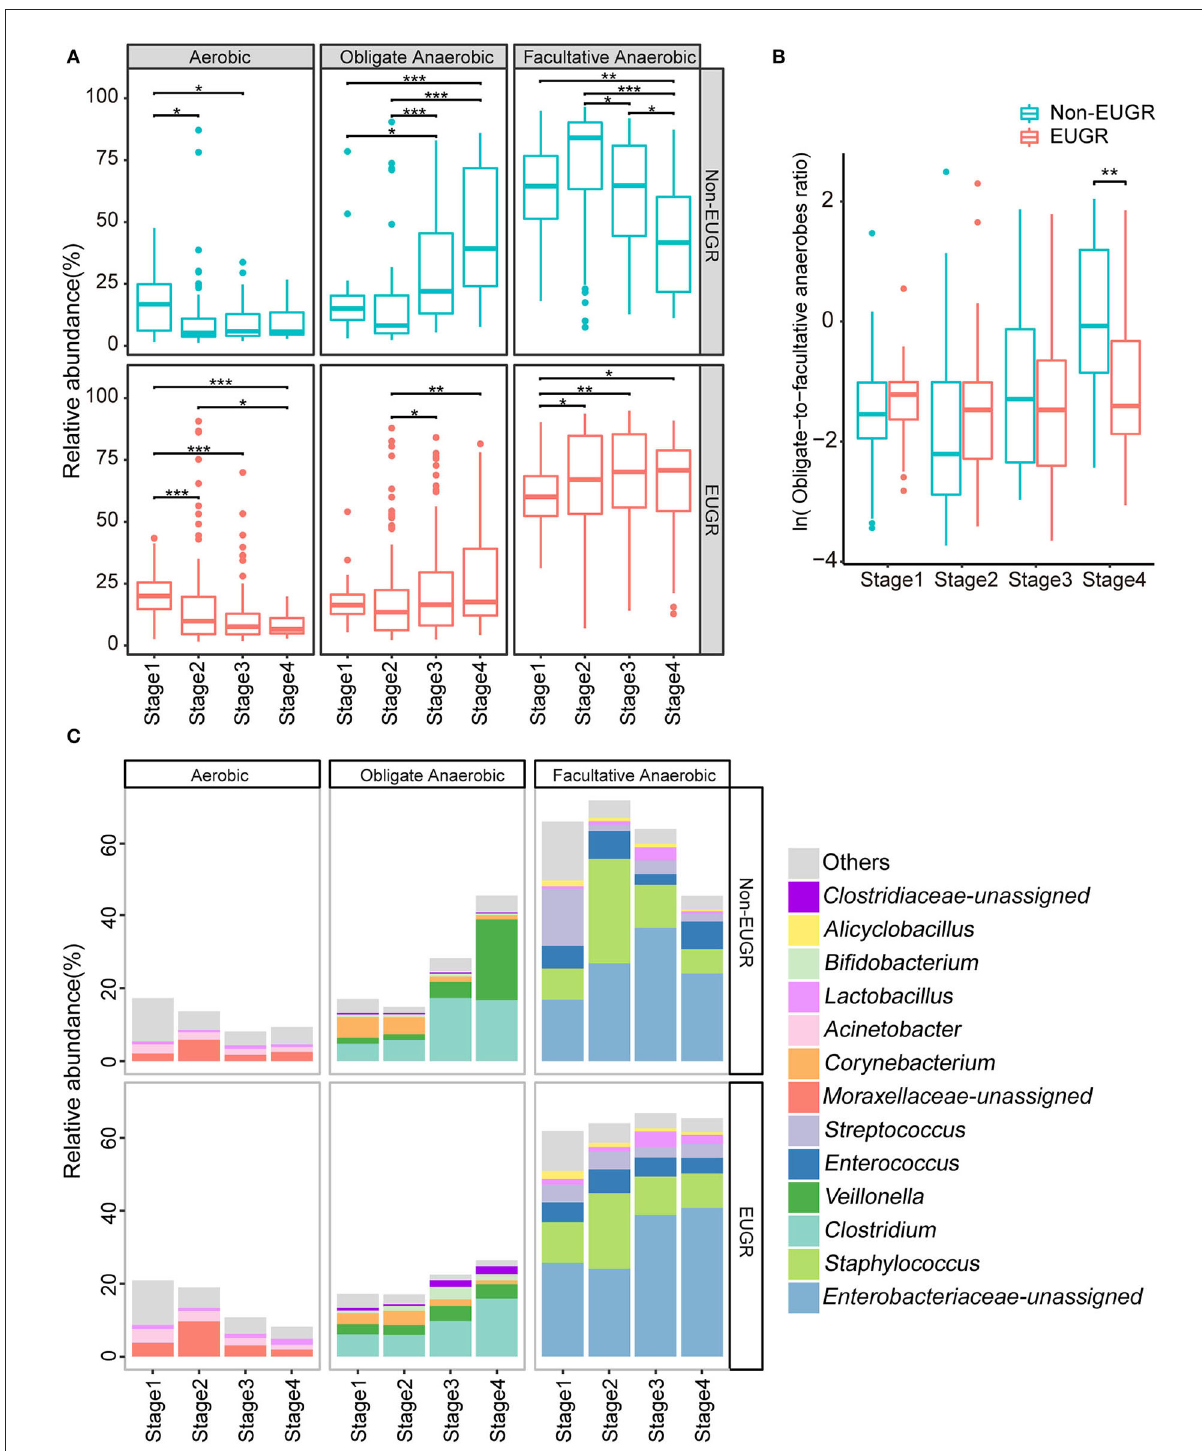
FIGURE2 Dynamics of bacterial oxygen utilizing phenotypes in the EUGR and non-EUGR groups. (A) The dynamics of aerobic, obligate anaerobic, and facultative anaerobic in the four stages for the EUGR and non-EUGR groups. The differences among stages were tested using Kruskal–Wallis test, followed by Wilcoxon rank-sum test. (* p < 0.05; ** p < 0.01; and *** p < 0.001). (B) The dynamics of obligate-to-facultative anaerobes ratio in the four stages for the EUGR and non-EUGR groups. The differences between the EUGR and non-EUGR groups were tested using Wilcoxon rank-sum test. (C) Microbial composition dynamics in the four stages at the genus level for preterm birth infants with and without